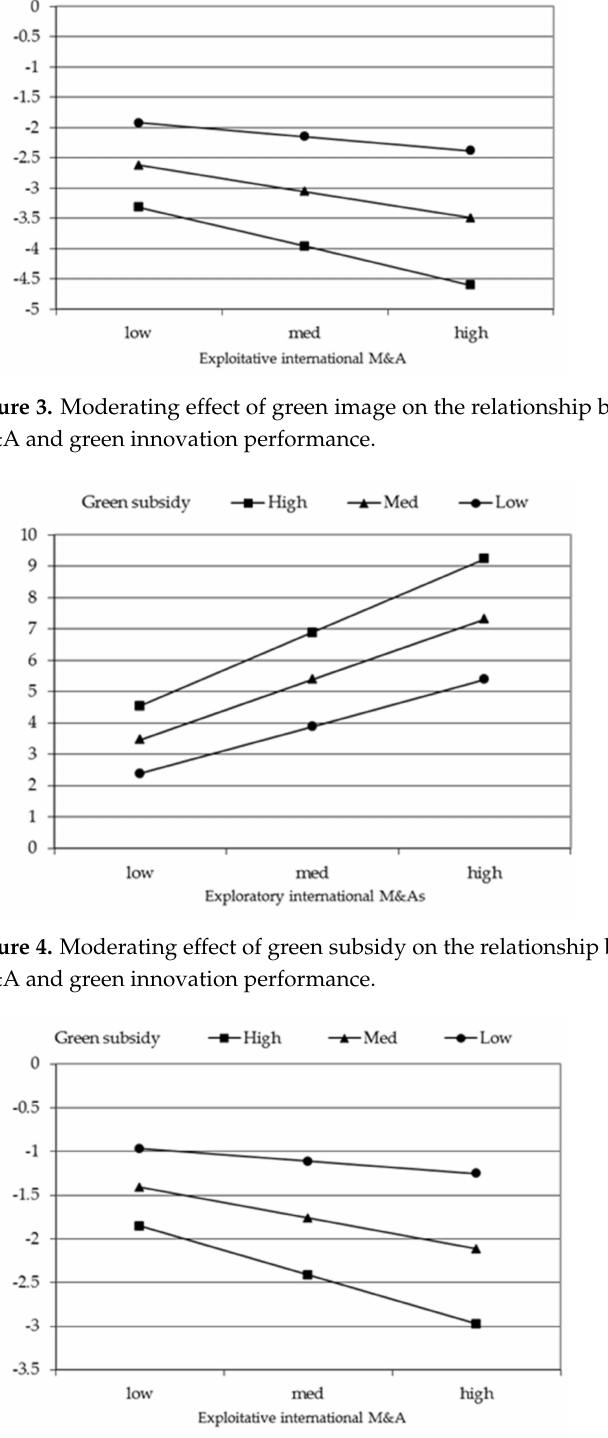
Figure 5. Moderating effect of green subsidy on the relationship between exploitative international M&A and green innovation